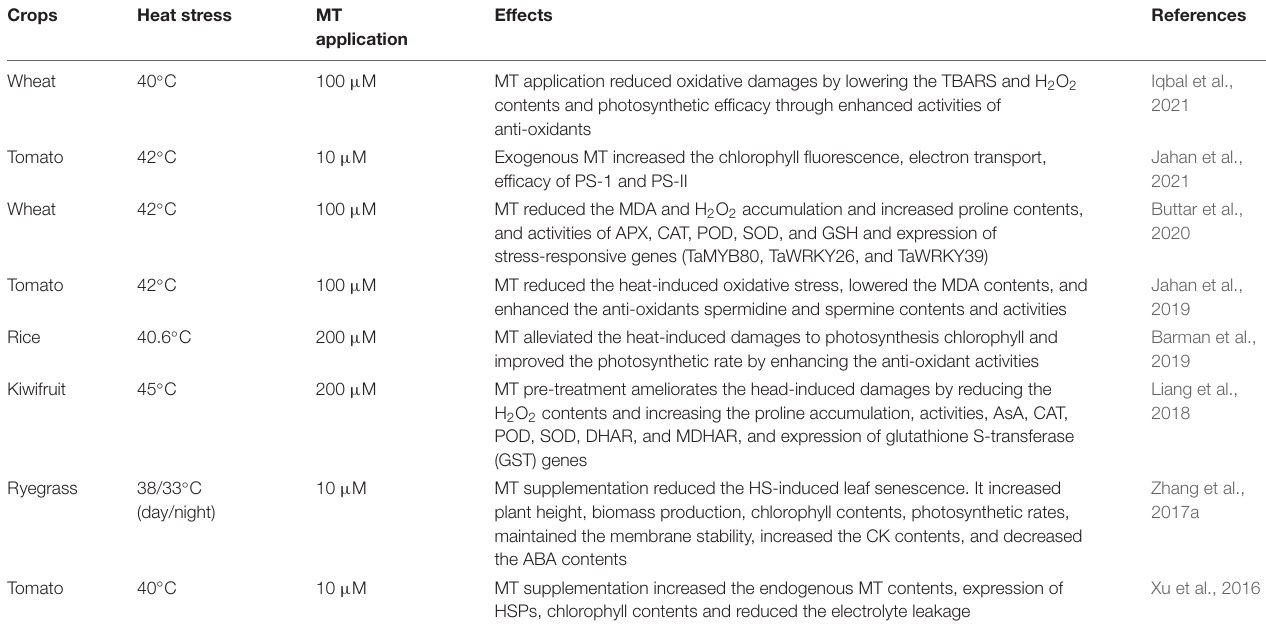
TABLE 4 | Role of melatonin in inducing heat stress tolerance in different plant species.